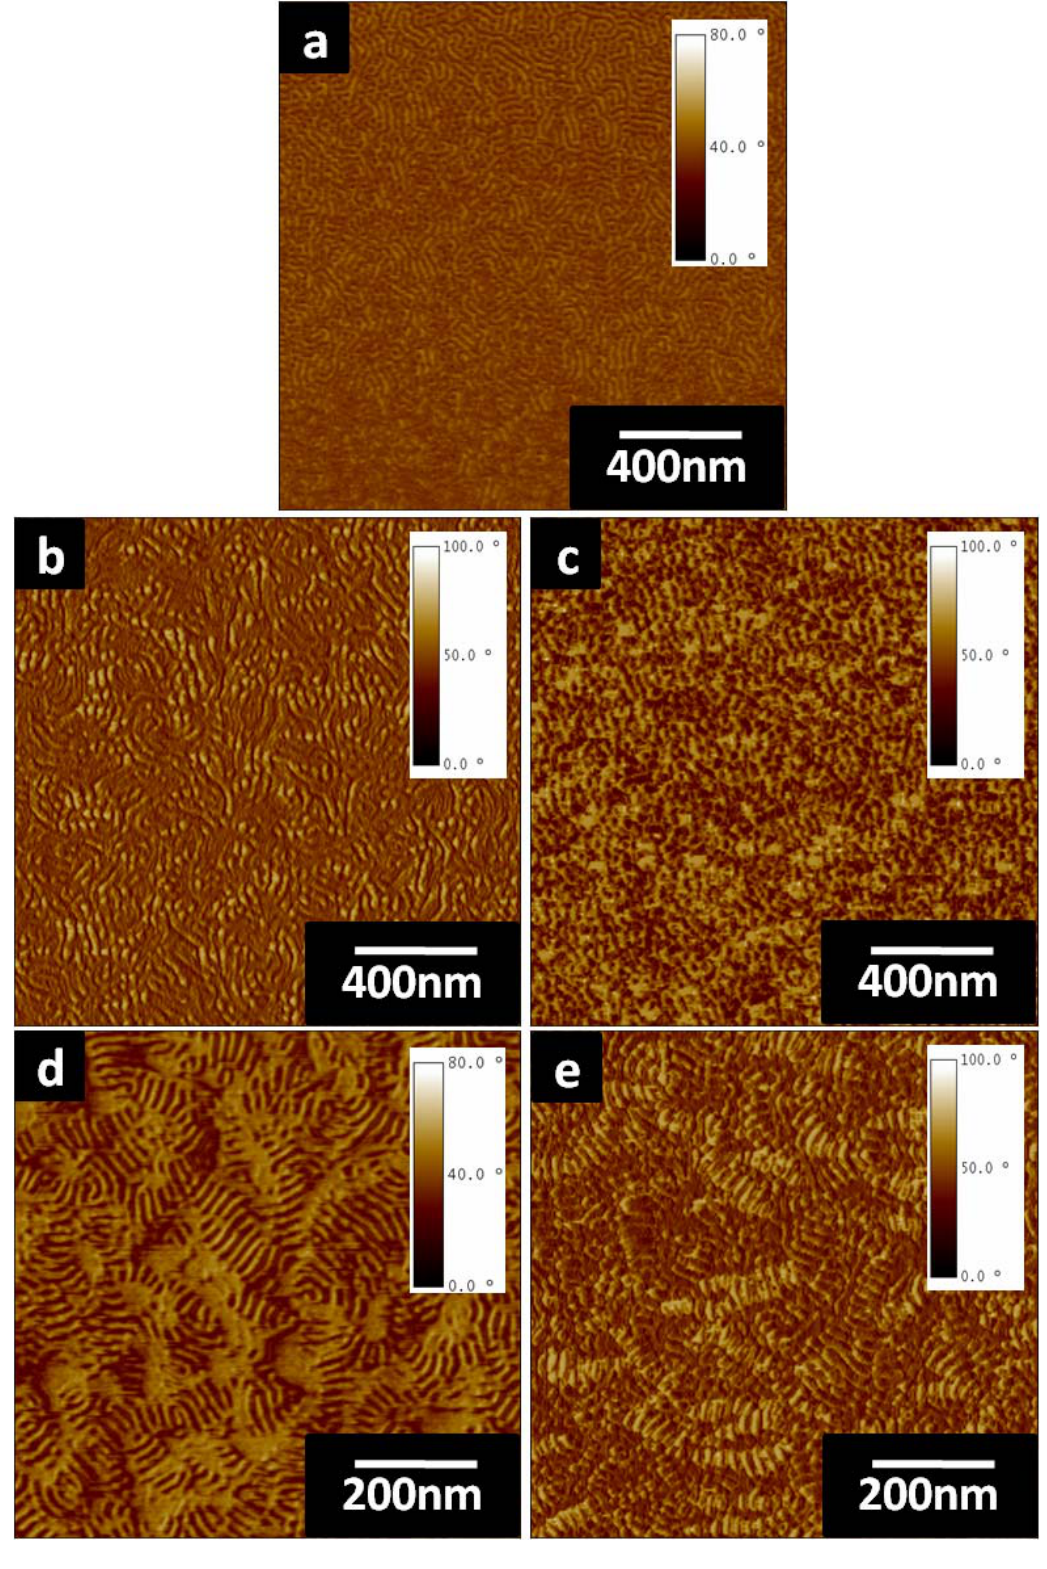
Figure 2. Phase contrast AFM images of the surfaces of (a) neat PS- b -PEO film; -TiO film containing 10 vol% inorganic precursors; (c) identical film in (b) PS- b -PEO/SiO 2 2 (b) after removing the BCP templates; (d) PS- b -PEO/SiO -TiO film containing 20 vol% 2 2 inorganic precursors; (e) identical film in (d) after removing the BCP templates. The hybrid films were prepared from spin coating dioxane solutions. The Ti/Si mass ratio is